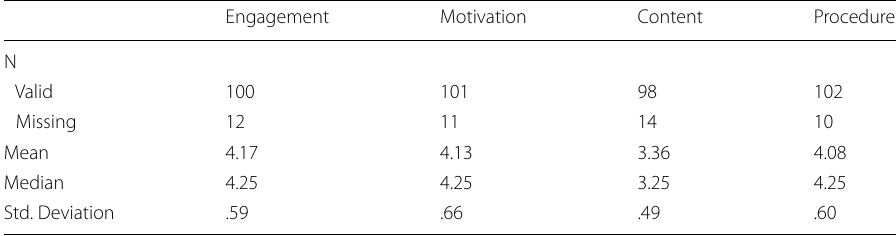
Table 3 Student perceptions on bridge Simulation